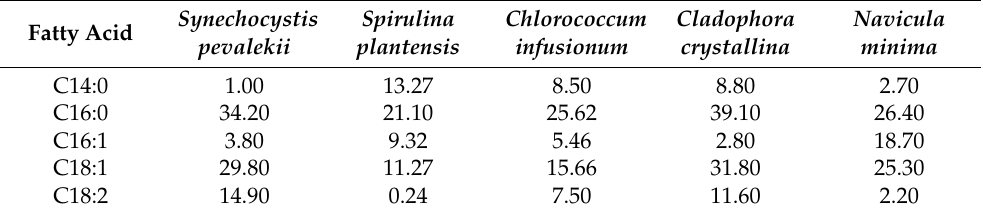
Table 2. Major fatty acid composition of some selected species of microalgae [22]. Fatty